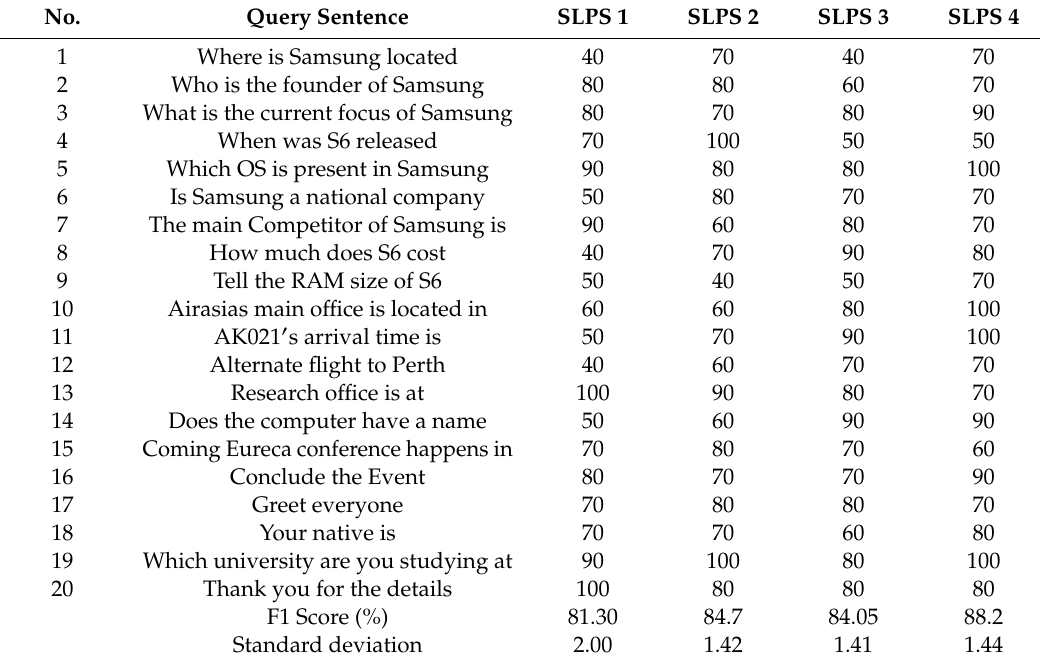
Table 6. F1 scores of various Spoken Language Processing System (SLPS) implementations.